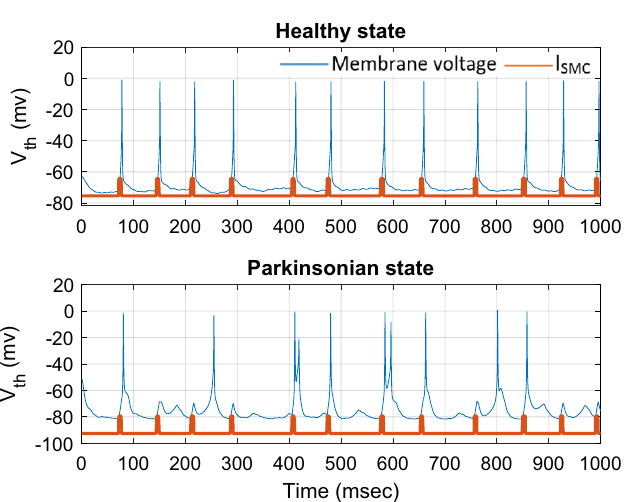
Figure 2. Closed-loop diagram of the proposed robust AFTSMC for control of Parkinsonian state through adaptive continuous DBS pulses. Tracking error, e ( t ) , is achieved by comparing the output of the healthy model, x d ( t ) , and the actual model, x ( t ) . The fuzzy estimators receive the voltages of TH neurons as inputs and calculate the elements of f 1 vector and F 2 matrix as main parts of the nonlinear dynamic model of the TH (see details in Appendix D of the Supplementary Materials). f 1 , F 2 and tracking error e ( t ) are used to compute the final control input u ( t ) .